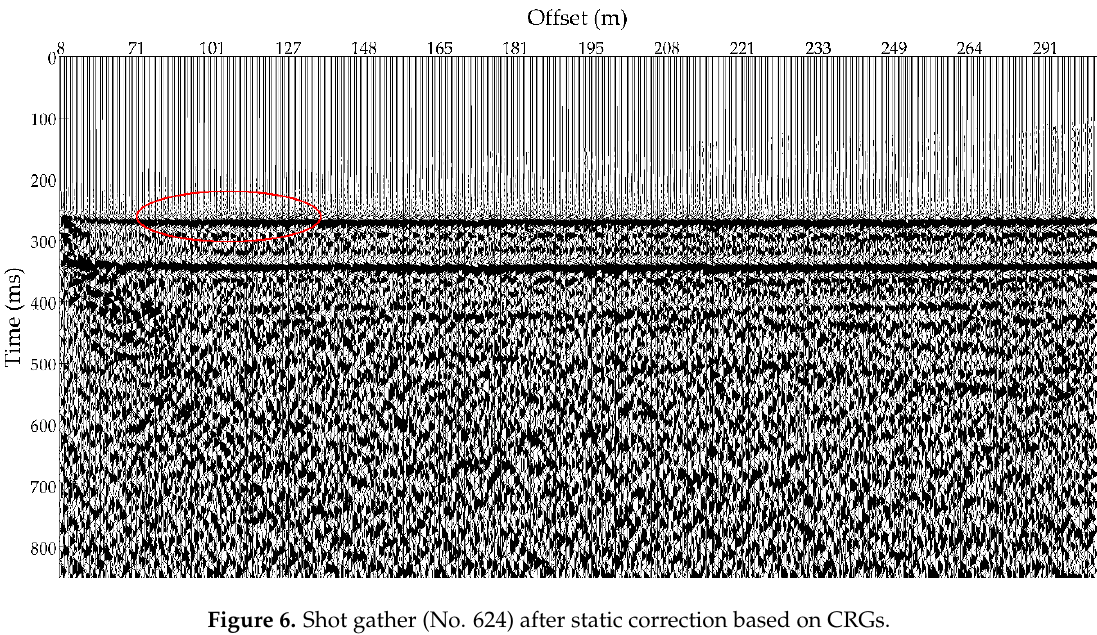
Figure 6. Shot gather (No. 624) after static correction based on CRGs.